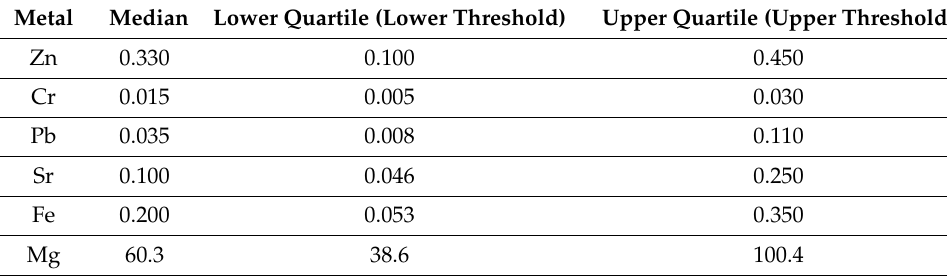
Table 3. Variational indicators of metal content urine ( µ